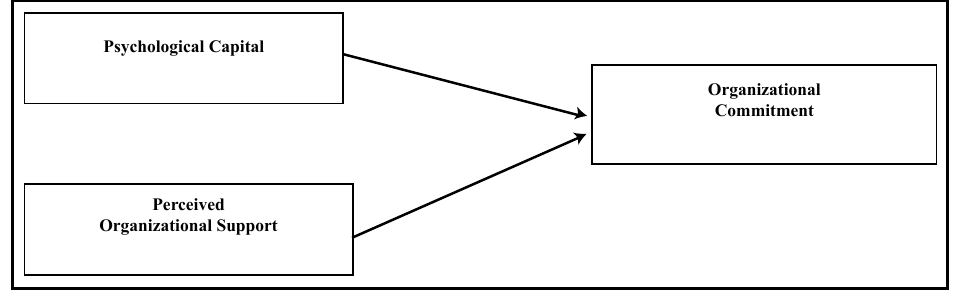
Figure 1: Research